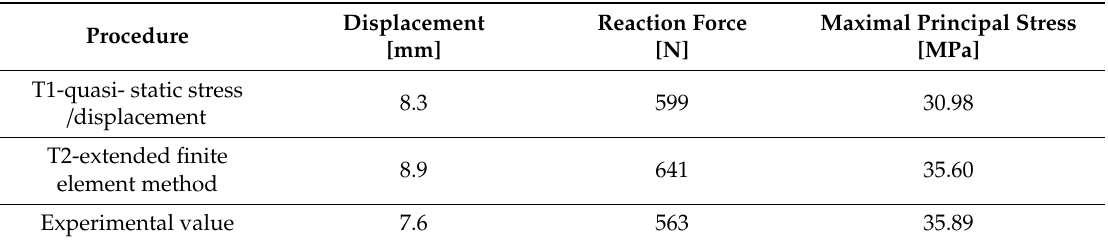
Table 6. Magnitudes of displacements, reaction forces, and maximal principal stress for first approach (T1) and second approach (T2) finite element (FE) procedure, and experimental